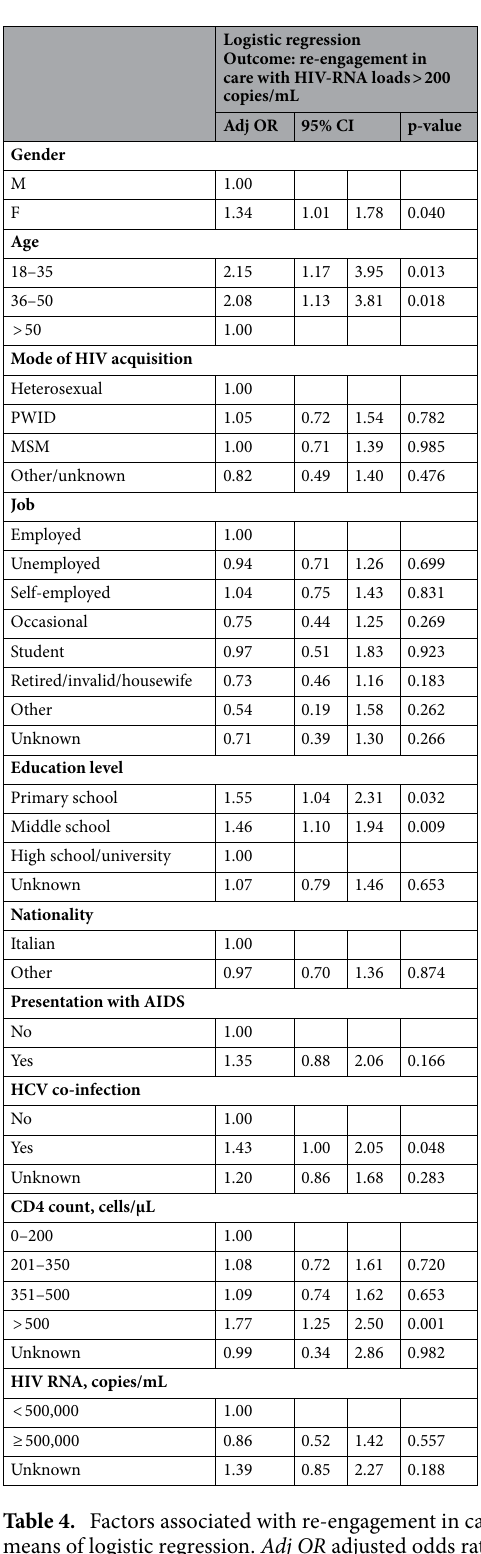
Table 4. Factors associated with re-engagement in care with HIV-RNA > 200 copies/mL vs LTC no RIC by means of logistic regression. Adj OR adjusted odds